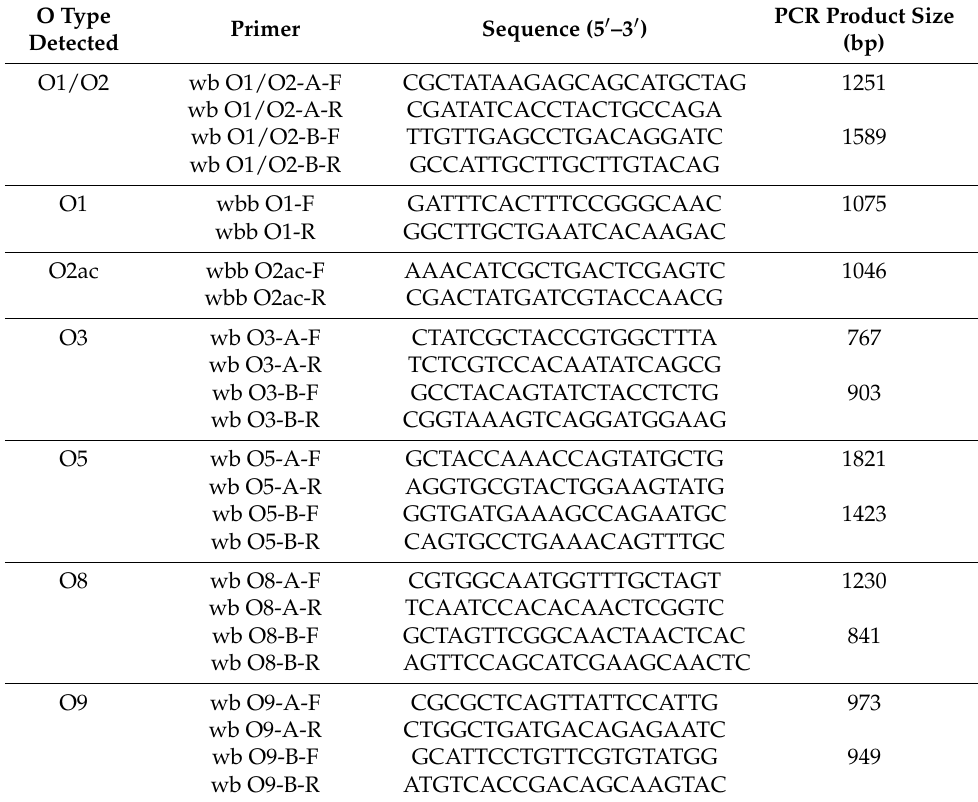
Table 1. Primers used for K. pneumoniae LPS O genotyping by